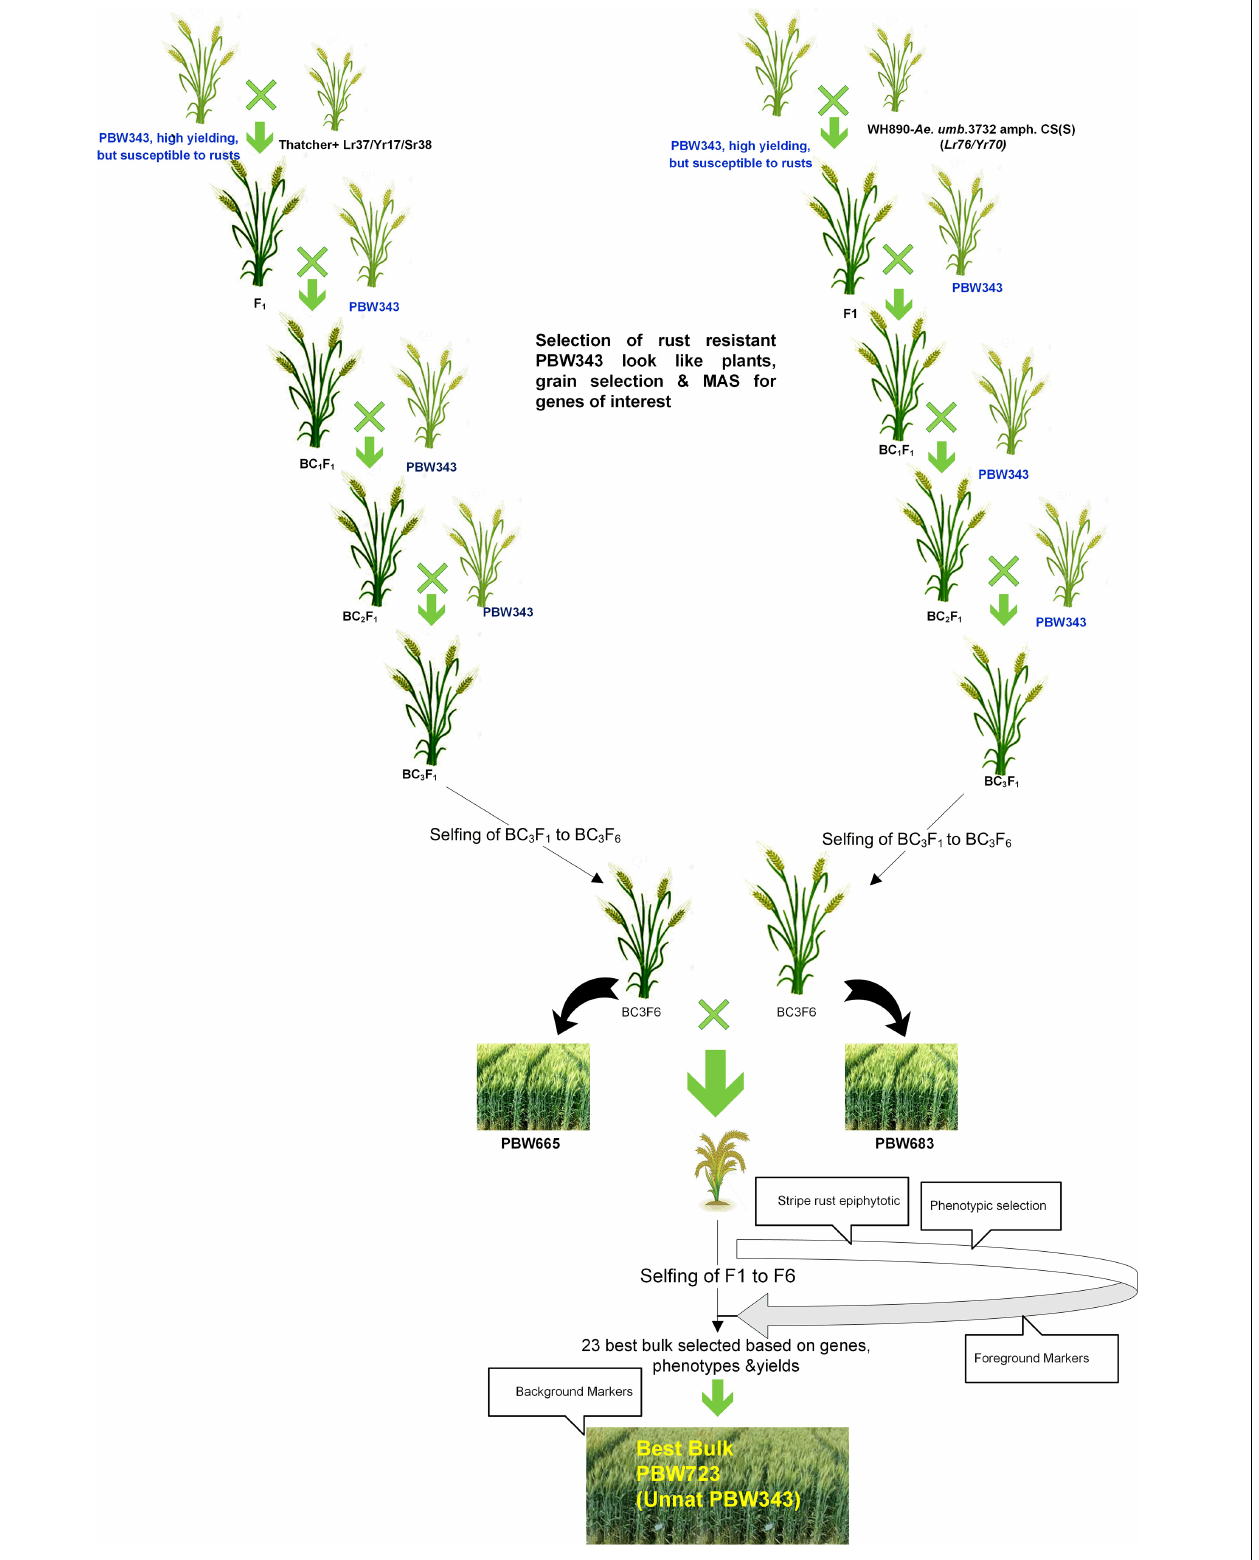
Frontiers in Plant Science |